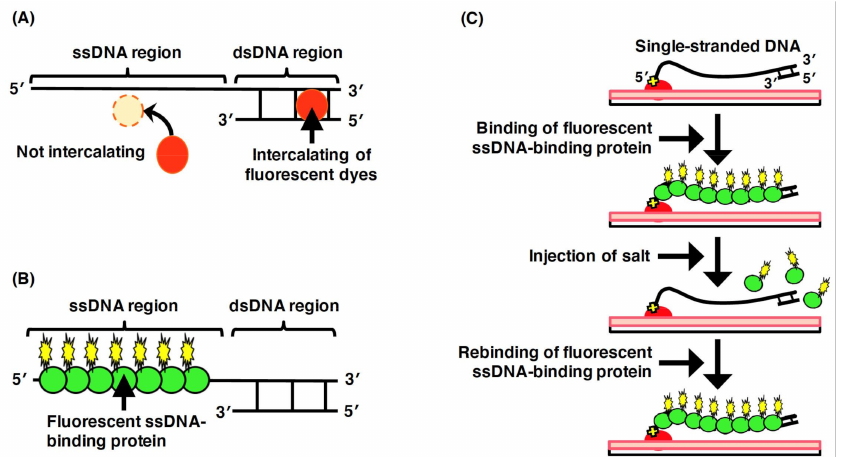
Figure 8. Labeling of the single-stranded regions of single DNA molecules with fluorescent ssDNA- binding proteins. ( A ) Staining the double-stranded region of a DNA molecule with an intercalating dye. The single-stranded region is not stained with an intercalating dye. ( B ) Labeling of the single-stranded regions of DNA molecules with fluorescent ssDNA-binding proteins. ( C ) Schematic illustration of the dynamic behavior of the single-stranded DNA molecules labeled with fluorescent ssDNA-binding protein. One end of ssDNA molecule was specifically immobilized on modified glass surface, and then, fluorescent RPA molecules were injected into the flow cell, resulting in the binding of fluorescent RPA to the ssDNA molecules. The dynamic behavior of the physical form of ssDNA molecule was monitored with and without fluid flow. When salt was added at more than 200 mM, the fluorescent RPA molecules were released from the ssDNA molecule. The ssDNA was restained with the fluorescent RPA after removing the salt. Refer to [166] for